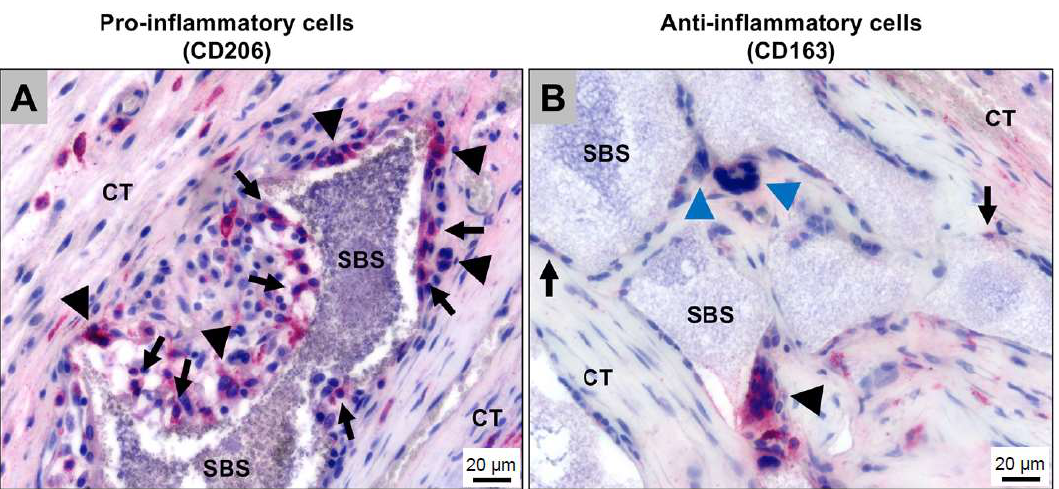
Figure 8. Histological images showing the immunologic alignment of both macrophages and multinucleated giant cells (MNGCs) within the bony implantation bed of a synthetic bone substitute (SBS). CT: connective tissue. ( A ) Detection of pro-inflammatory mononucleated (arrows) and multinucleated cells (arrowheads) at the bone substitute granule surfaces (CD206-immunostaining); ( B ) Detection of anti-inflammatory mononuclear (arrows) and multinucleated (black arrowhead) cells at the bone substitute granule surfaces. Interestingly, most of the MNGCs that were adherent to the bone substitute granules (blue arrowheads) did not show an expression of the anti-inflammatory molecule (CD163-immunostaining).